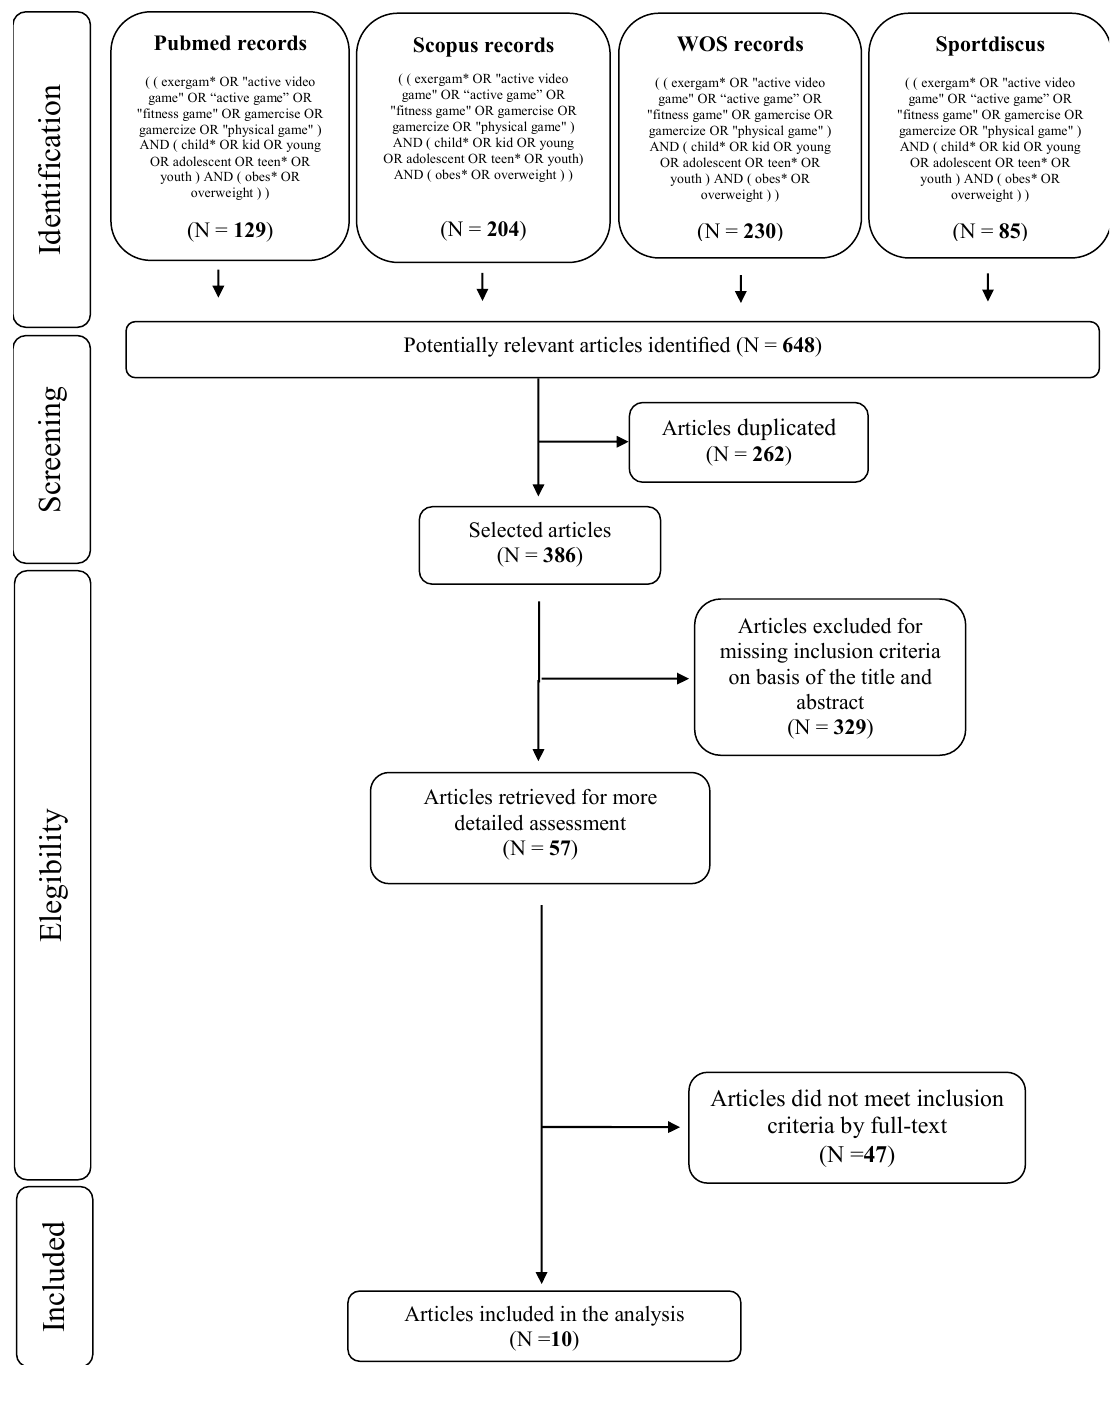
Figure 1. Flow-chart of search strategy.